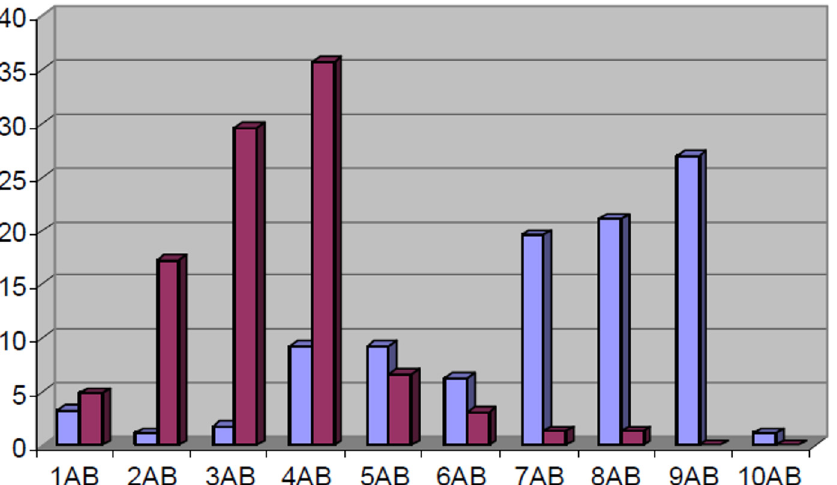
Fig 2. Dynamical distribution of multi-resistance in veal calves. Proportion of strains ( Y -axis, %) resistant for indicated number of antibiotics ( X -axis: 1AB; resistance to 1 agent tested, 2AB; resistance to 2 agents tested, etc.) of faecal E . coli (N = 506) retrieved during the production cycles at T1 (blue bars; 4 weeks +- 5 days after arrival, N = 276) and T2 (red bars; 24 weeks +- 5 days after arrival, N = 230) from 5 veal calves